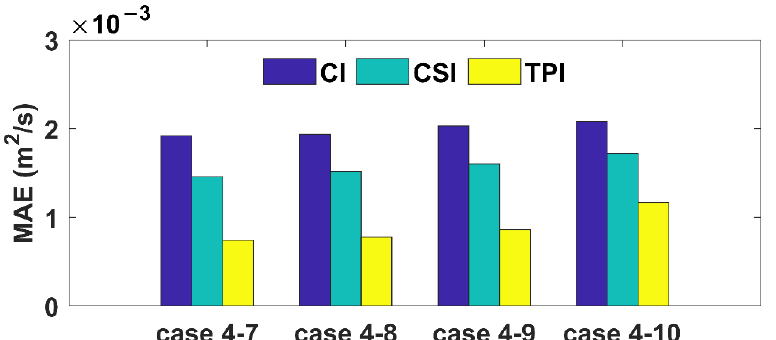
Figure 8. The MAEs between the given and inverted VEVCs with the assimilation steps after adding 2%, 5%, 10%, and 15% errors.